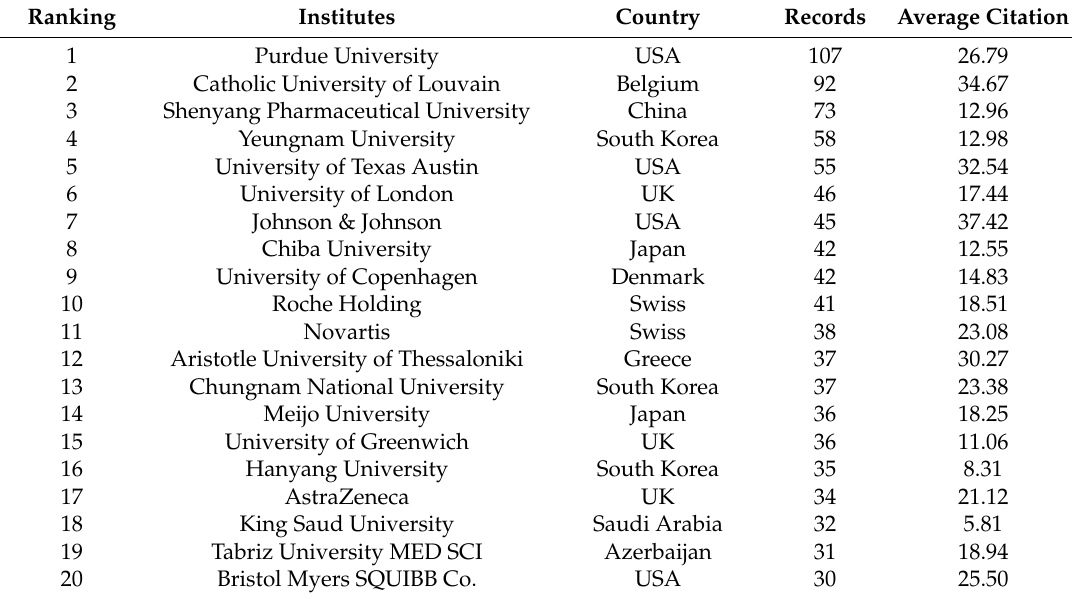
Table 2 . Productivity and impact of top 20 the most active institutions. Table 2. Productivity and impact of top 20 the most active